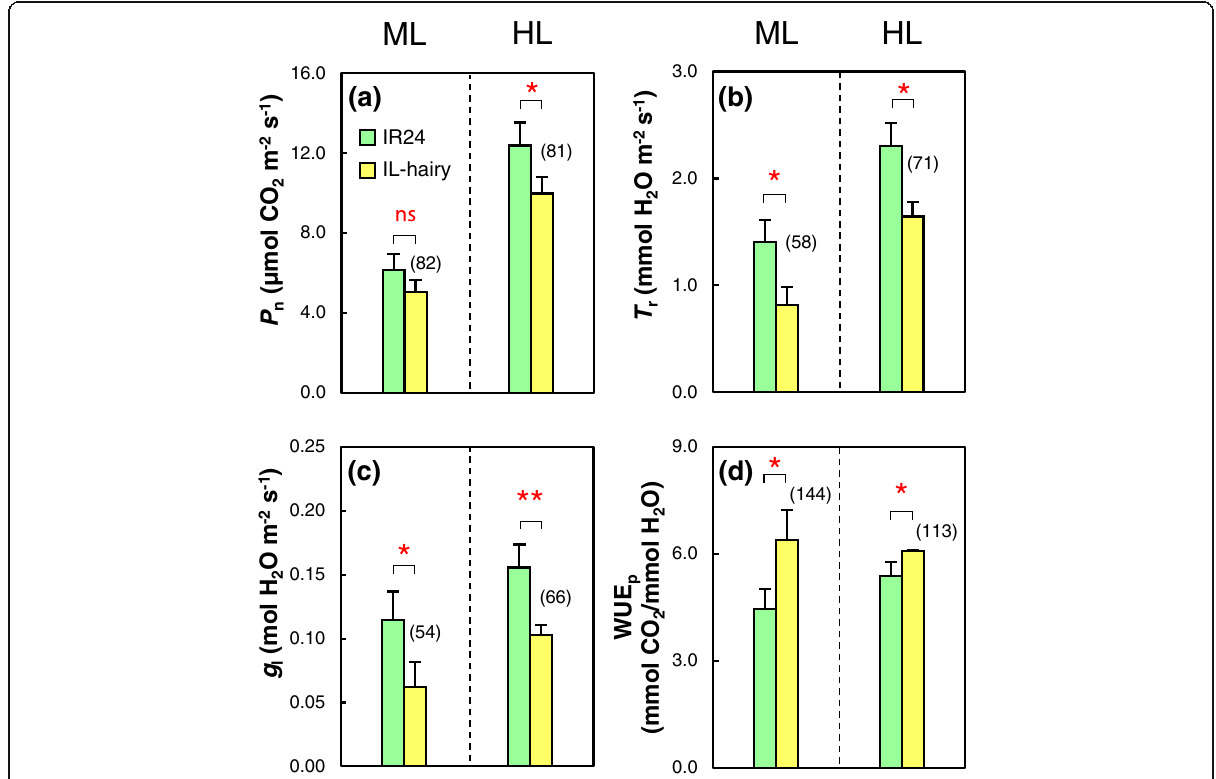
Fig. 4 Photosynthetic traits in IR24 and IL-hairy. Net photosynthetic rate ( P n ; a ), transpiration rate ( T r ; b ), leaf diffusive conductance ( g l ; c ), and photosynthetic water use efficiency (WUE p ; d ) under moderate (ML: 400 μ mol m − 2 s − 1 ) and high light intensity (HL: 1500 μ mol m − 2 s − 1 ) at booting stage. Data are means ± SD ( n = 3 or 4). * P = 0.05, ** P = 0.01; ns, not significantly different ( t -test). Values in parentheses show percentage of IL-hairy values relative to IR24 values Os06g0659100 and Os06g0663500 were identified as OsSPL10 and OsSPL11 ( SQUAMOSA PROMOTER BINDING PROTEIN-LIKE ( SPL ) genes in O. sativa ), and phylogenetic analysis of SPL genes in rice and Arabidop- sis placed OsSPL10 and AtSPL8 in group B, and OsSPL11 , AtSPL2 , AtSPL10 , and AtSPL11 in subgroup A2.2 (Yang et al. 2008). An AtSPL8 -knockout mutant obtained by transposon tagging showed disrupted trich- ome formation (Unte et al. 2003). Transgenic plants ex- pressing a dominant repressor version of SPL10/11/2 formed many trichomes on their cauline leaves and flowers (Shikata et al. 2009). Table 2 Stomatal density and guard cell length, specific leaf weight, chlorophyll content, and nitrogen content of leaves at the booting stage in IR24 and IL-hairy Guard cell Specific Line Stomatal density length leaf wt. (no. mm − 2 ) ( μ m)